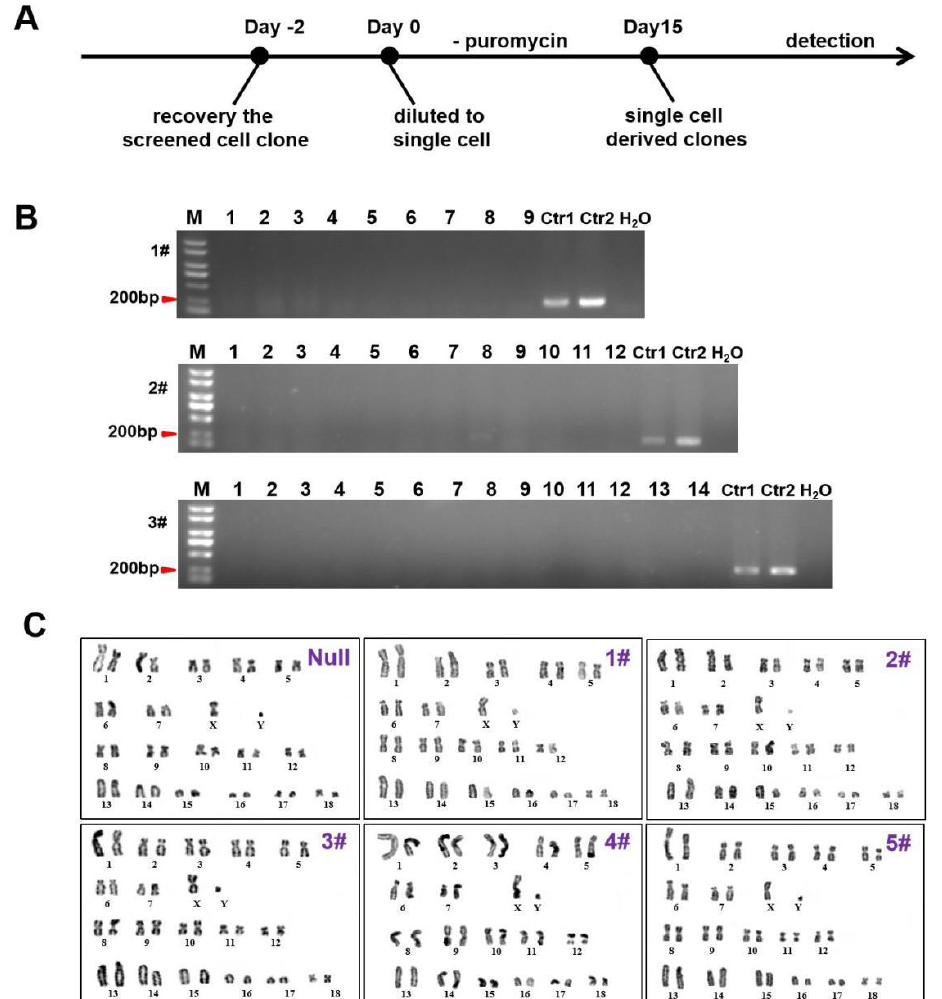
Figure 4. The MAIO-epiCBE plasmid did not integrate into host cells and influence the karyotype of modified cells. ( A ) Schematic of eliminating the MAIO-epiCBE plasmid by withdrawal of puromycin. ( B ) The absence of MAIO-epiCBE plasmid in single-cell-derived clones was demonstrated by PCR with primers: episomal-F and episomal-R. Ctrl1 is the positive control amplified from MAIO-epiCBE vector genome with primers: episomal-F and episomal-R. Ctrl2 is the positive control amplified from the genome of ST cell containing the MAIO-epiCBE plasmid. ( C ) The karyotype analysis of null and five ST cell clones.